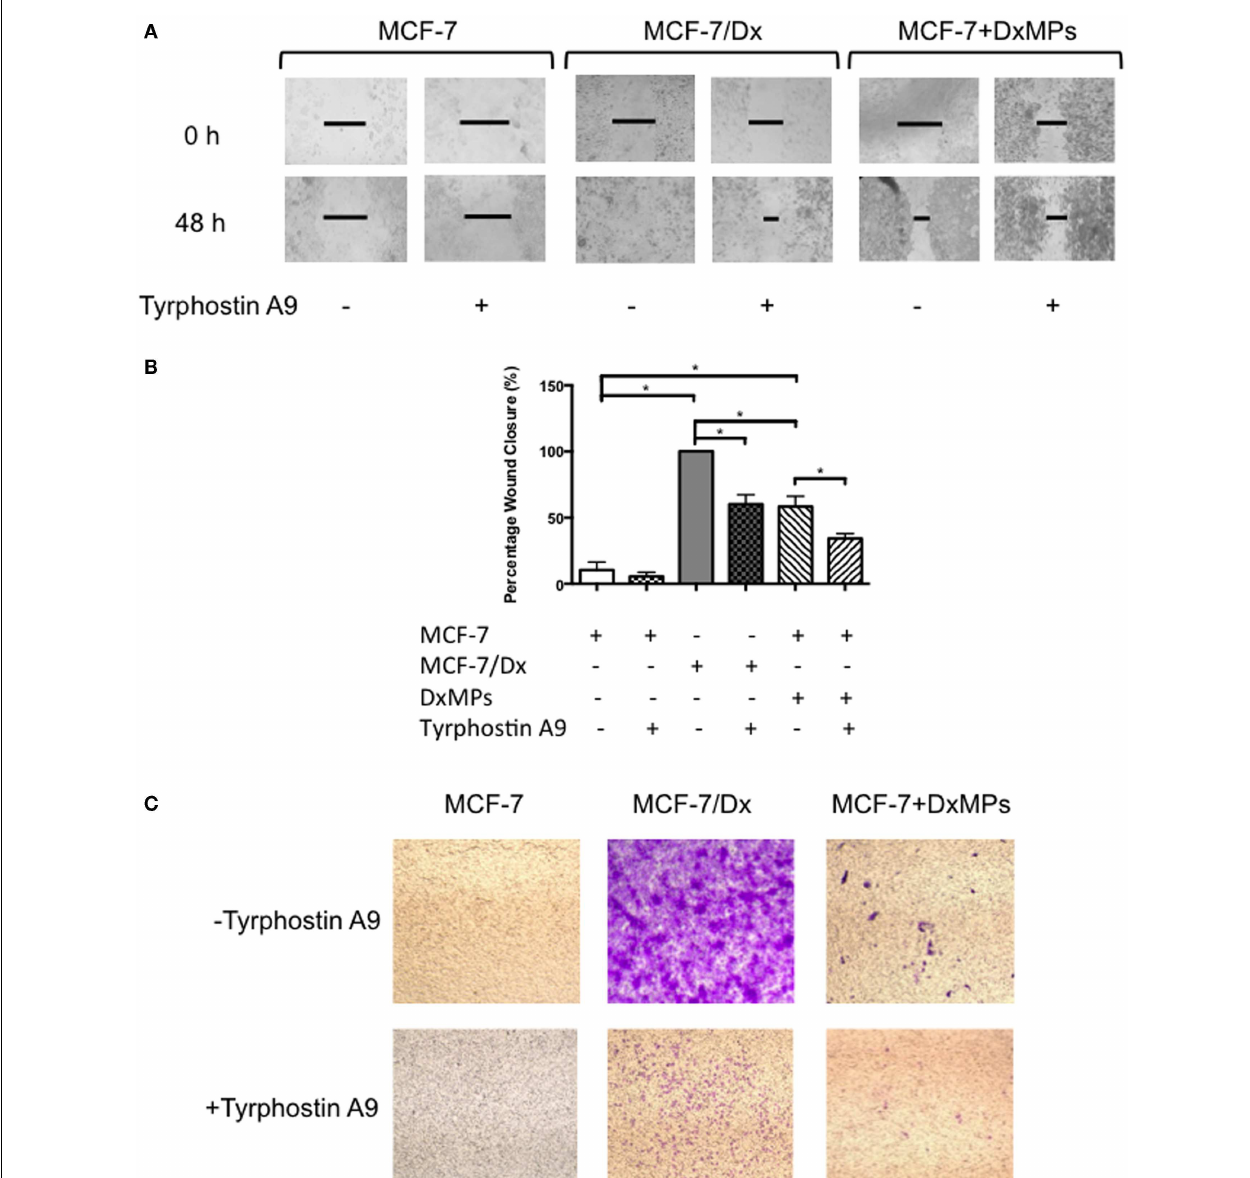
without tyrphostin A9, ( ): MCF-7/Dx cells with tyrphostin A9, ( ): MCF-7 cells co-cultured with DxMPs without tyrphostin A9, and ( ): MCF-7 cells co-cultured with DxMPs with tyrphostin A9. Data represent mean ± SEM of at least three independent experiments. * p < 0.05. (C) Inhibition of PYK2 phosphorylation is associated with decreased invasive capacity. Transwell insert invasion by MCF-7 cells, MCF-7/Dx cells, and co-cultured cells demonstrate the invasive capacity of each cell type and the effect of tyrphostin A9 on this capacity. Cells were incubated without or with tyrphostin A9 and the invasion of cells through a Matrigel ® layer to the underside of transwell membranes was assessed after 48h. Data was representative of at least three independent experiments.